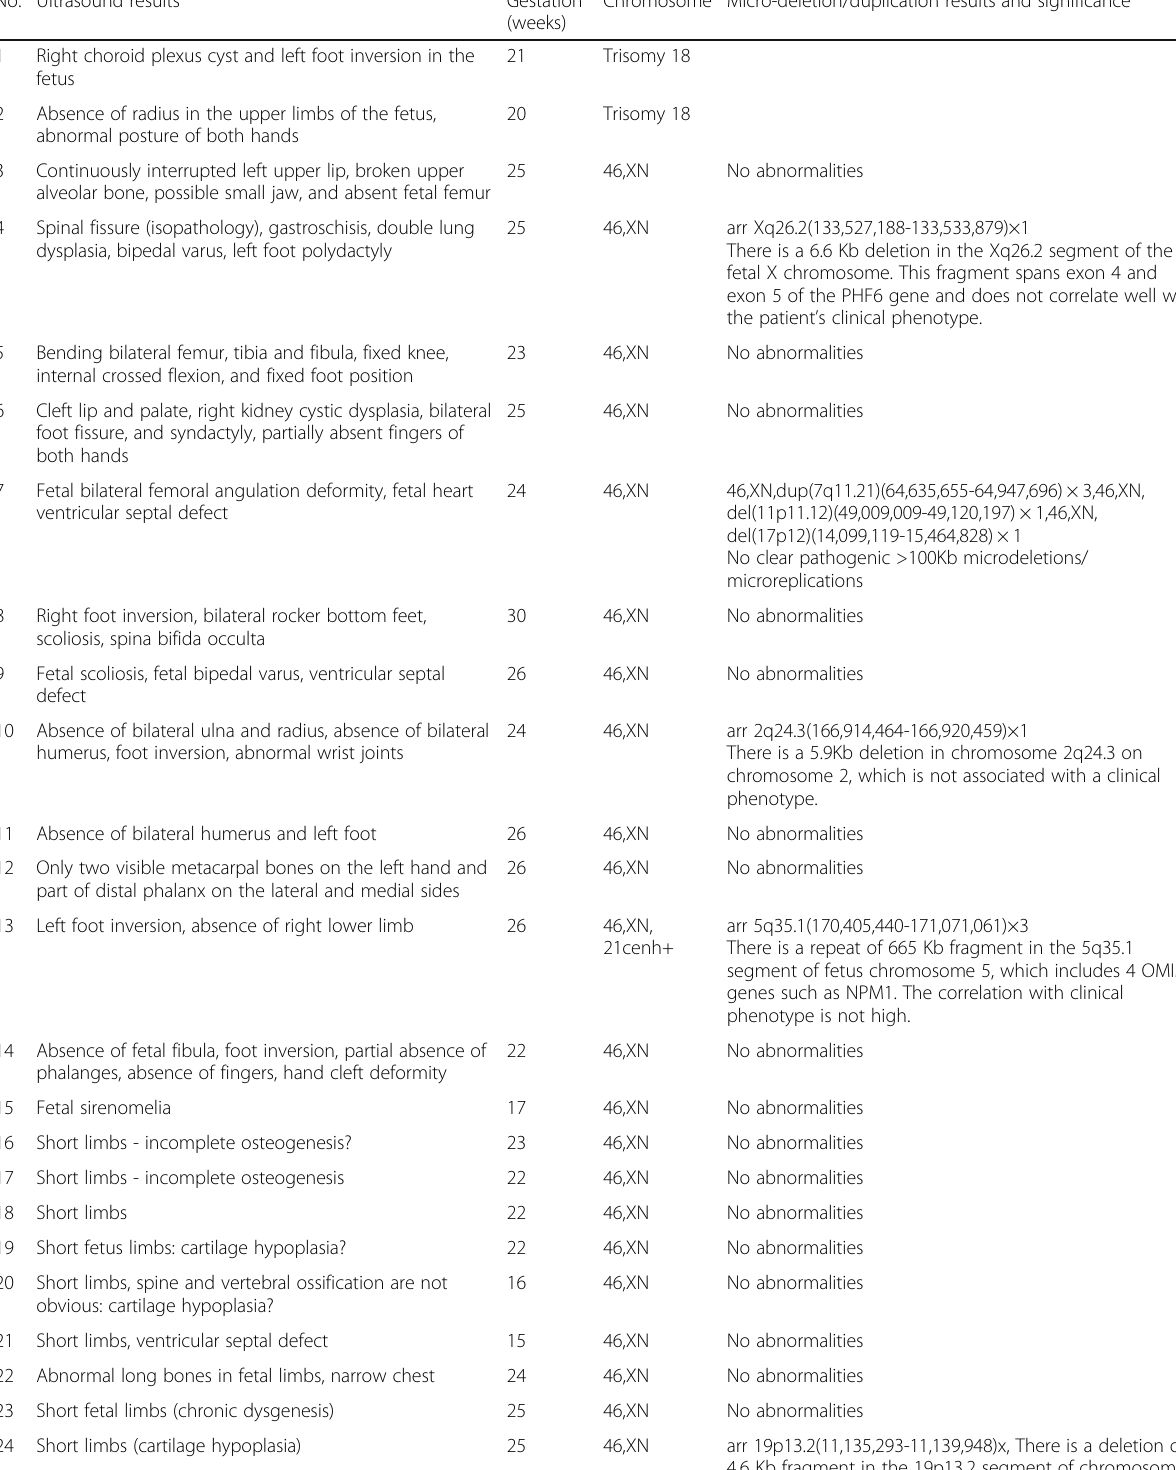
Table 1 General data for 30 cases of fetal skeletal dysplasia, including chromosome information and microdeletion/microduplication test